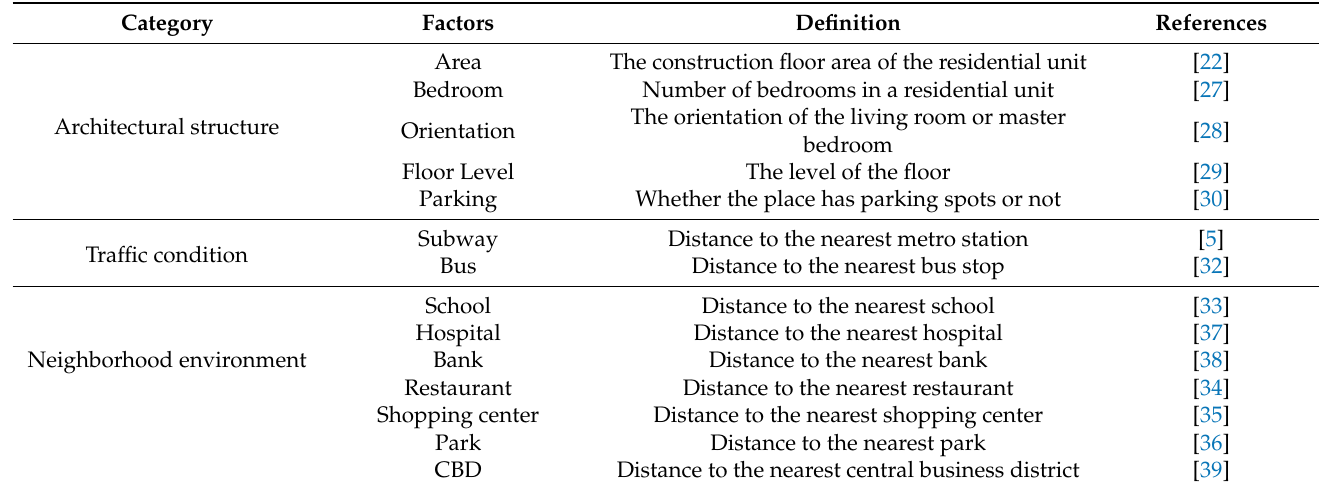
Table 1. Factors that influence rental housing